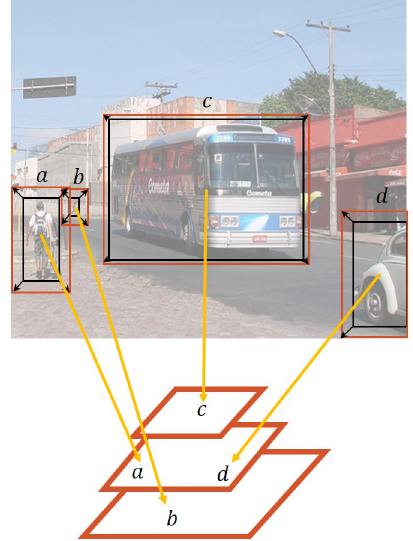
Figure 3. The structure of Adaptive Context Expansion